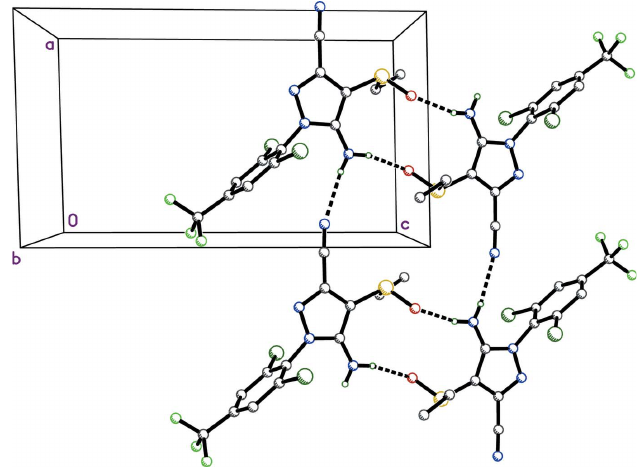
Figure 3 A packing plot viewed down the b -axis showing strong hydrogen bonds (dashed lines) that form R 4 (18) and R 2 (12) ring motifs. Hydrogen atoms 4 2 not involved in hydrogen bonding are omitted for the sake of clarity.